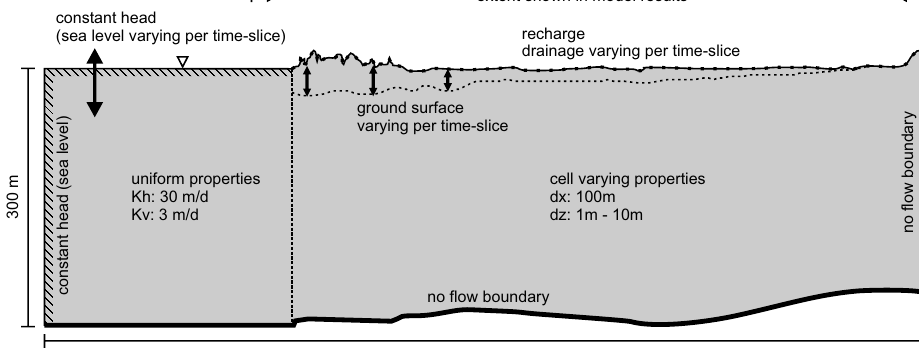
Figure 3. Conceptual model